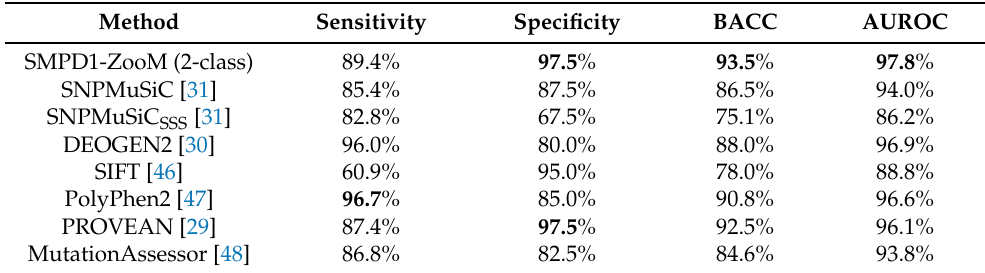
Table 3. Two-class classification scores of commonly used deleteriousness predictors and the 2-class version of our 3-state SMPD1-specific predictor SMPD1-ZooM on the S 2 cl dataset. Highest scores are in bold.